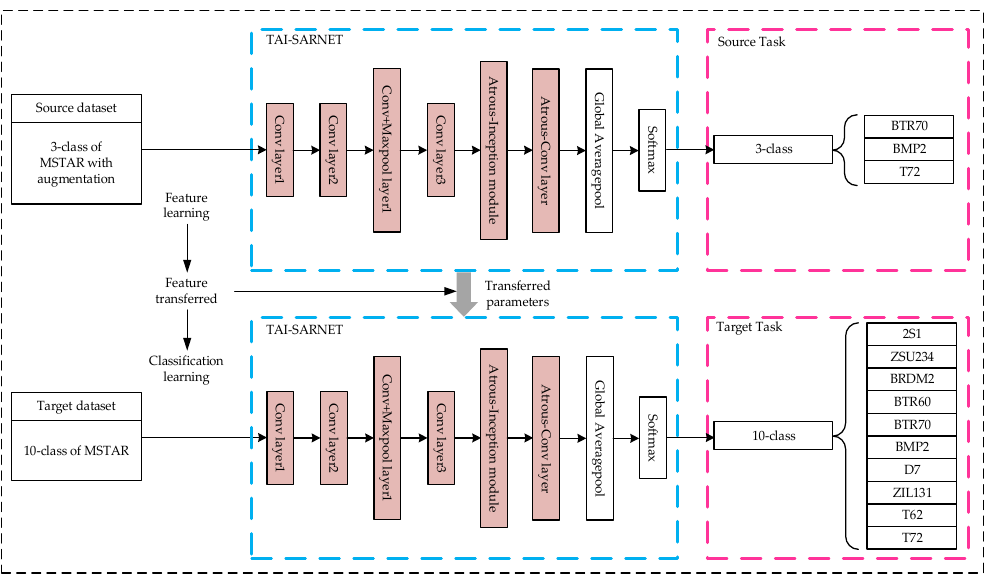
ZSU234 Figure 6. MSTAR dataset image example. Table 2. 10-class MSTAR dataset configuration under Standard Operating Condition (SOC).